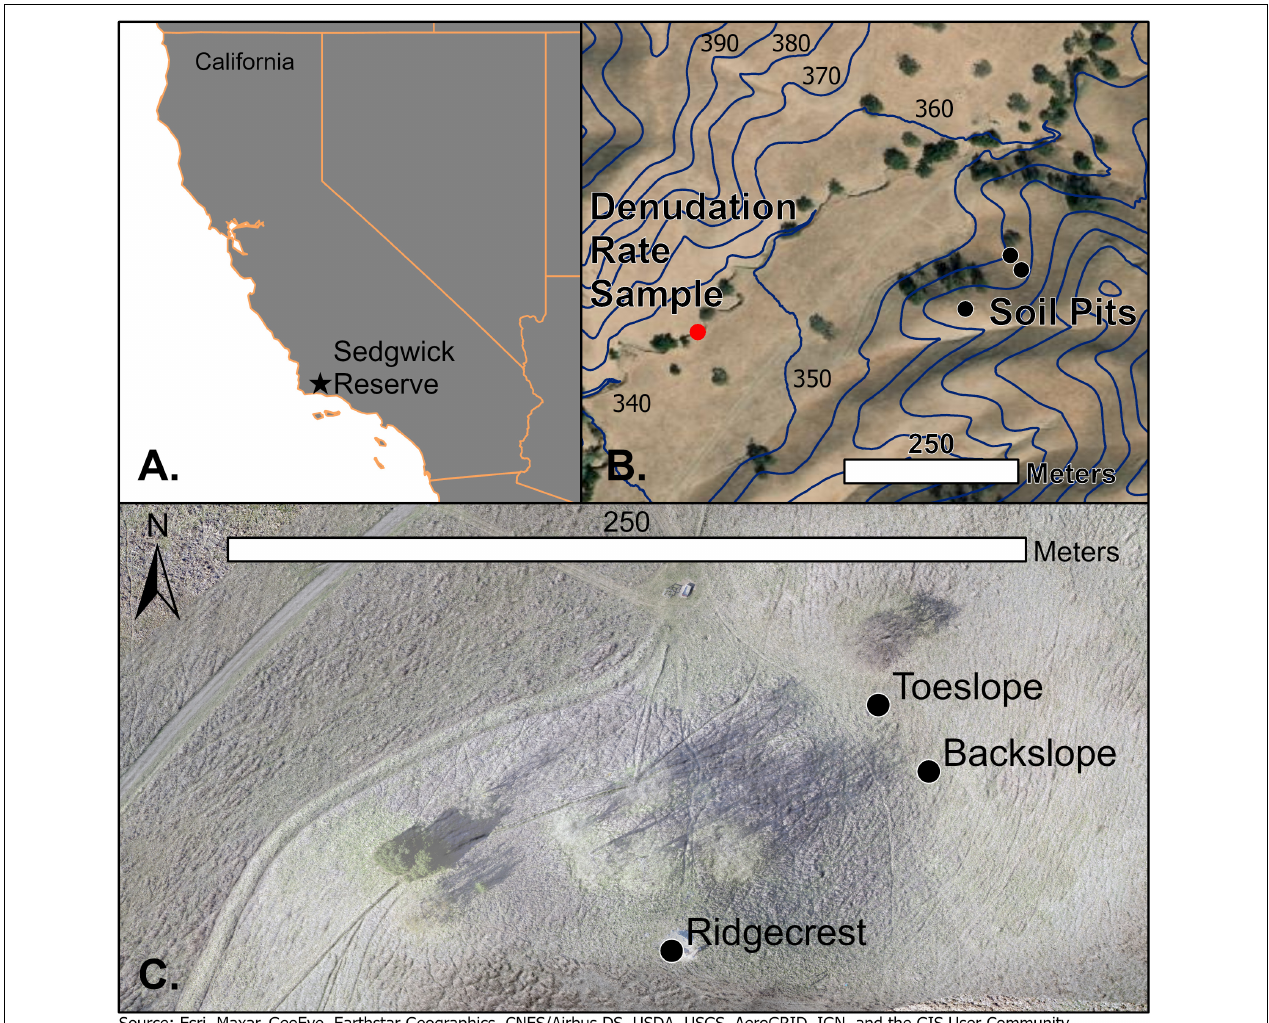
FIGURE 1 | (A) Location of Sedgwick UC Field Reserve. (B) Soil (black points) and denudation sample locations (red point) within Sedgwick Reserve. Navy blue 10-m elevation contours lines show change in elevation across study site. (C) Ridgecrest, backslope, and toeslope soil sampling locations (black